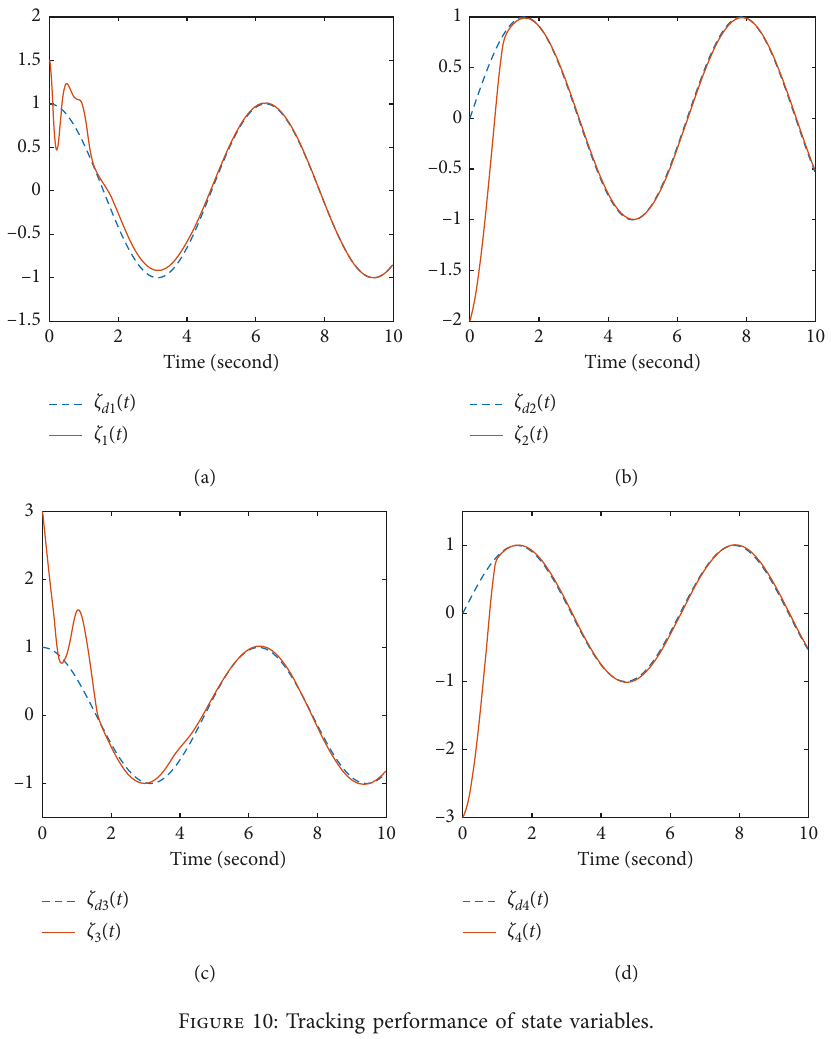
Figure 10: Tracking performance of state variables.